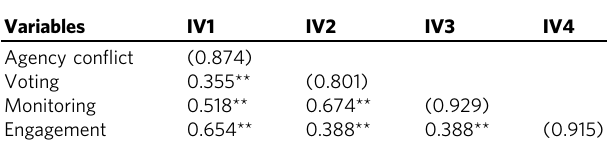
Table 3 Pearson correlation.